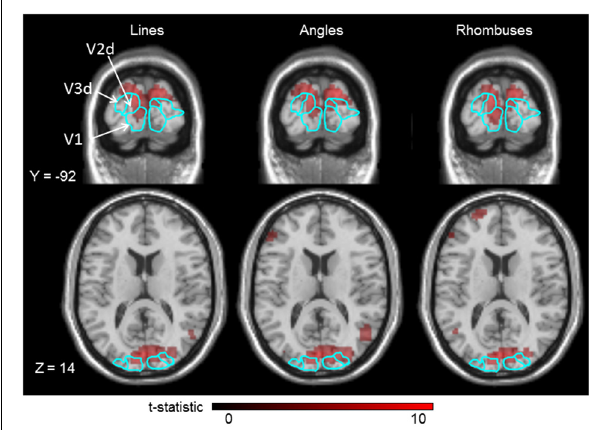
FIGURE 4 | Activation levels (averaged across nine subjects) in visual areas V1, V2d, and V3d for lines, angles, and rhombuses presented to either the nasal or the temporal visual quadrant. Visual areas were mapped retinotopically in each subject. Standard errors of the mean are indicated by error bars. White, shaded, and filled columns indicate activation level for lines, angles, and rhombuses respectively, derived from the BOLD signal.